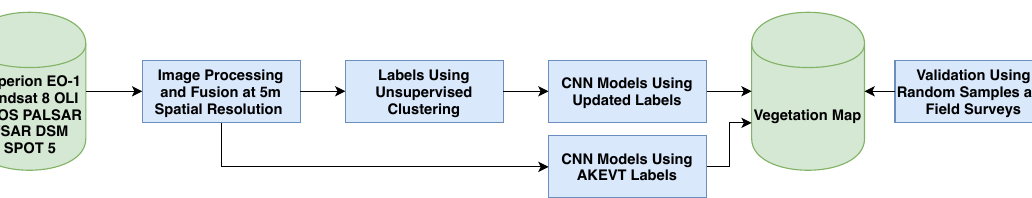
Figure 2. Workflow for the processing of the remote sensing datasets and development of vegetation classifications. Image processing and fusion is described in Section 3.1. CNN model preparation is discussed in Section 3.3. Two sets of CNN models were created: (1) trained using the labels from the Alaska Existing Vegetation Type (AKEVT; http://akevt.gina.alaska.edu/) map and (2) trained using the labels from unsupervised clustering based vegetation map (discussed in Section 3.2). Validation